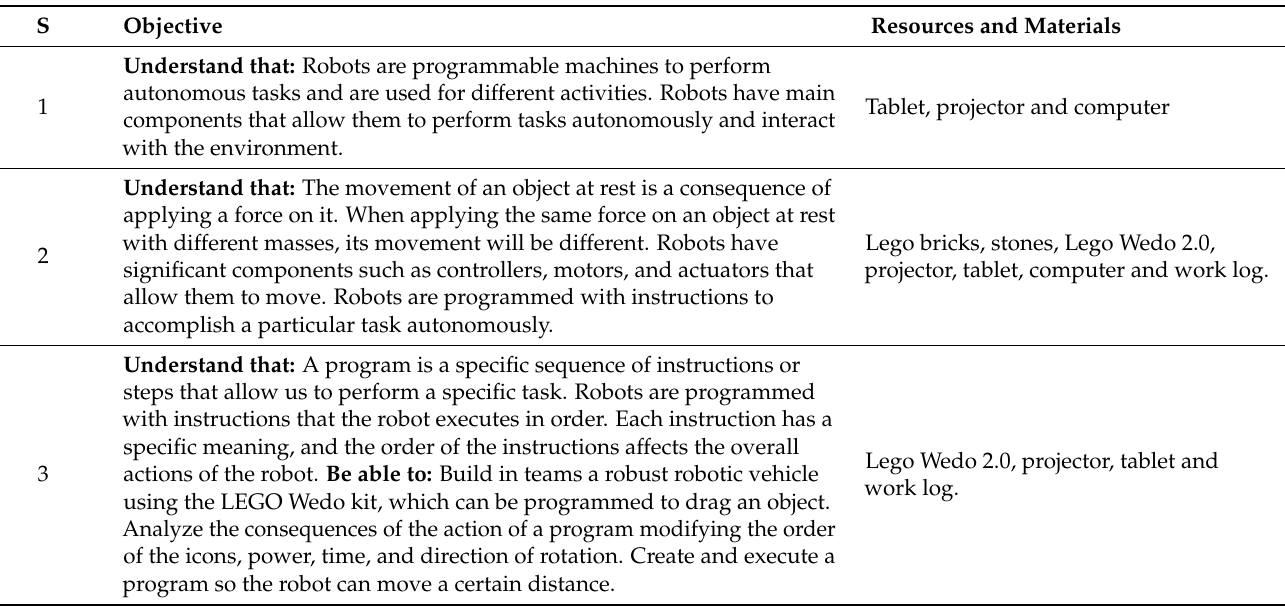
Table 2 lists the objectives of each session and the resources and materials used in them. Table 2. Objectives of each session and resources used. S indicates the session